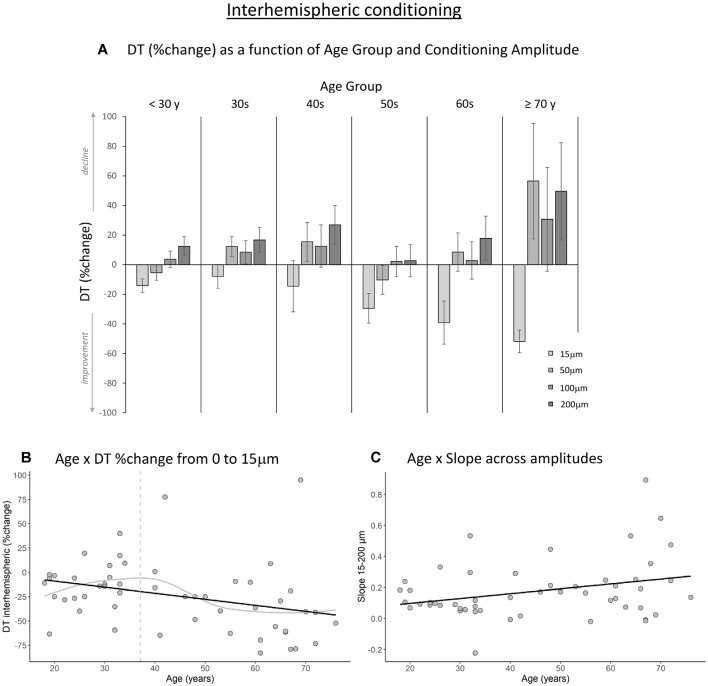
The effect of age on interhemispheric conditioning. (A) Detection threshold (DT; measured in %change compared to baseline) as a function of age group and amplitude of the conditioning stimulus. Data are plotted by age group for visualization purposes only; all analyses were conducted using age as a continuous variable. (B) The black line shows that with increasing age, DTs improved more when a conditioning stimulus (15 μm) was delivered to a contralateral homologous finger (p = 0.010). The gray line shows the LOESS smoothed age trajectory; the dashed line indicates the age at which changes started. (C) Relationship between age and the slope of DT change across the four amplitude conditions. With increasing age, DTs declined faster as a function of increasing conditioning stimulus amplitude (p = 0.029).